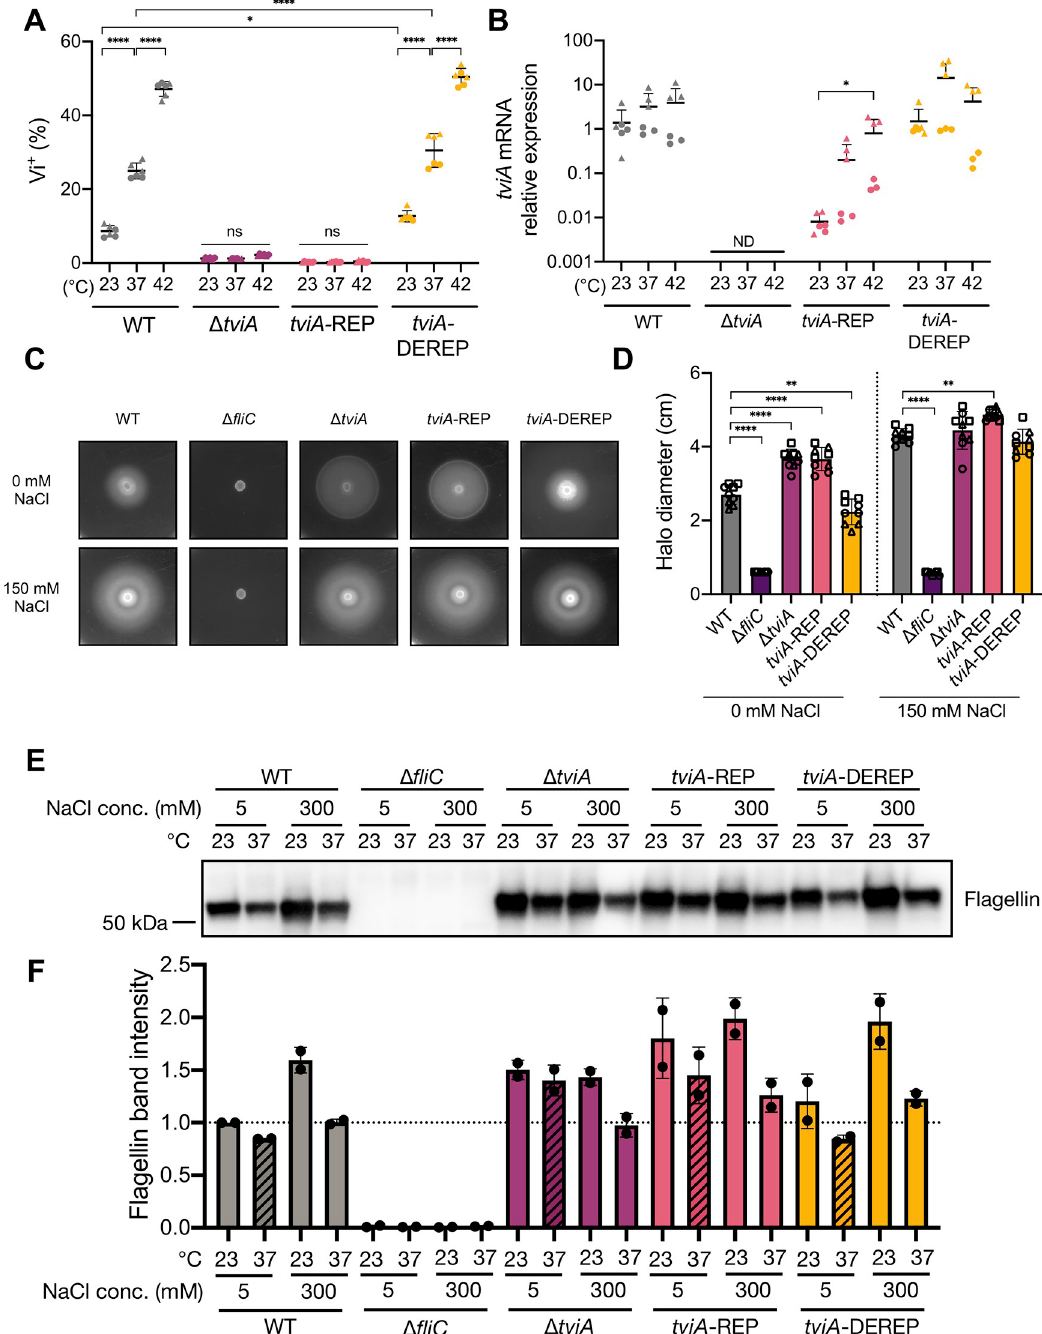
Fig 5. The tviA 5’ UTR fourU RNA thermosensor regulates virulence factor expression in a temperature-dependent manner. A) Quantitation of Vi capsule expression by flow cytometry of wild-type (WT), Δ tviA , tviA -REP (T90,92C), or tviA -DEREP (T89,91G;C93G) S . Typhi at ambient temperature (23˚C) or following a shift to human body temperature (37˚C) or fever-like temperature (42˚C) for 30 minutes. B) Relative expression levels of tviA mRNA of WT, Δ tviA , tviA -REP, or tviA -DEREP S . Typhi at ambient temperature (23˚C) or following a shift to human body temperature (37˚C) or fever-like temperature (42˚C) for 30 minutes. tviA mRNA levels normalized to 16S rRNA levels for each sample. C) Representative images of WT, Δ fliC , Δ tviA , tviA - REP, or tviA -DEREP S . Typhi grown on motility assay plates (0.3% agar) containing 0 mM or 150 mM NaCl at 37˚C for 24 hours. D) Measurement of halo diameter (in cm) of WT, Δ fliC , Δ tviA , tviA -REP, or tviA -DEREP S . Typhi grown on motility assay plates as described in 5C. E) Western blot for flagellin from whole cell lysates of WT, Δ fliC , Δ tviA , tviA -REP, or tviA -DEREP S .